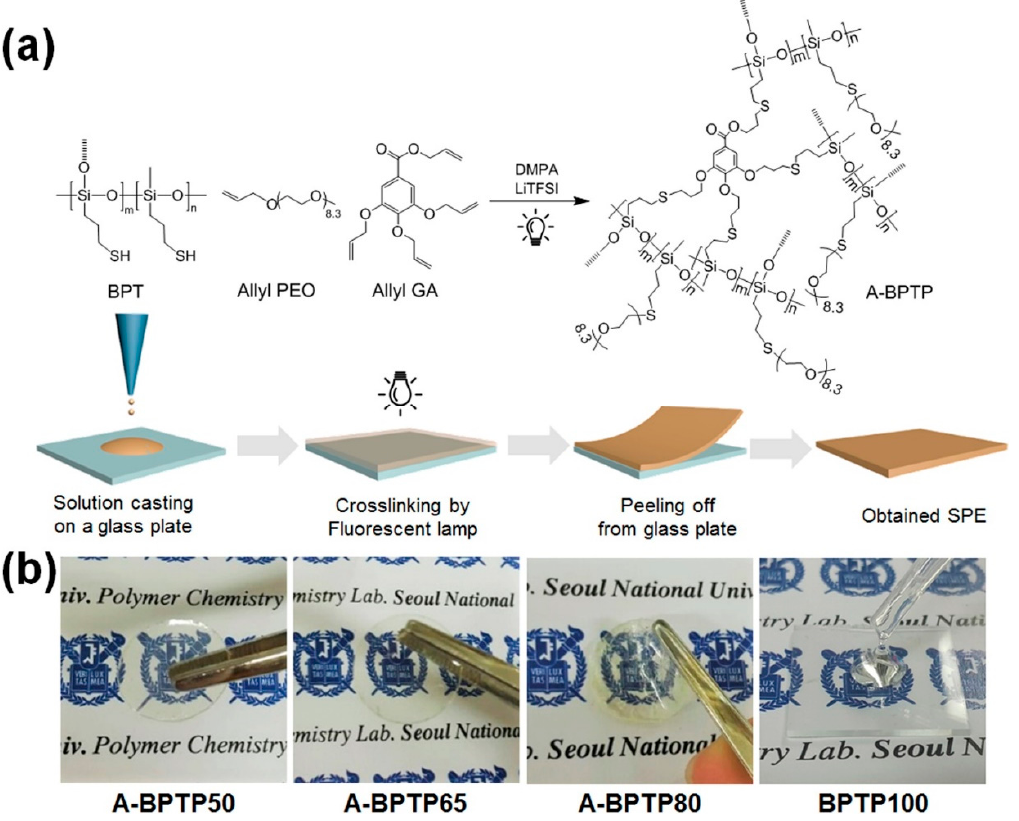
Figure 40. A material for lithium-ion batteries based on cross-linked polysiloxane. Re- printed/adapted with permission from Ref. [160]. (a) Preparation of A-BPTPs by thiol-ene click reaction under fluorescent lamp irradiation and (b) photographs of A-BPTPs having free-standing film states and BPTP100 having a wax state, where the number in the name indicates mol% of allyl PEO.